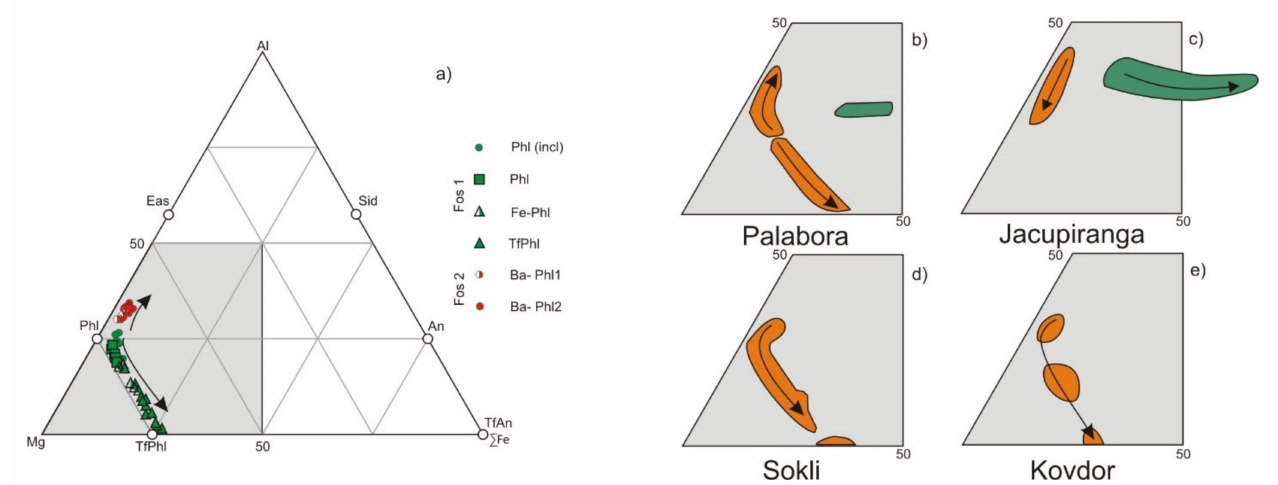
Figure 12. Trends of changes in mica of the Arbarastakh phoscorites ( a ) and other carbonatite complexes ( b – e ). Palabora [13], Jacupiranga [28], Sokli [51], Kovdor [34]. Green field—micas of accompanying silicate rocks, orange field—micas of carbonatites and phoscorites. Phl—phlogopite, TfPhl—teraferriphlogopite, TfAn—tetraferriannite, An—annite, Sid— siderophyllite, Eas—eastonite (data by [25], supplemented by the authors). Due to the absence of Ba in the graphs, the differentiation of phlogopites in the phlogopite—kinoshitalite and phlogopite—eastonite series is impossible in these graphs but is explained in the